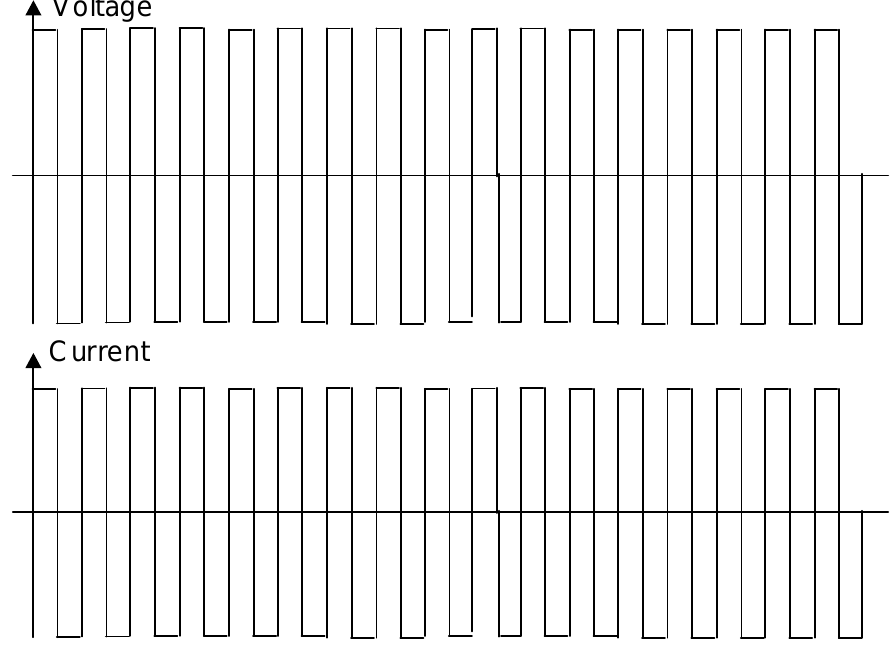
Figure 8: Current and voltage for pulse